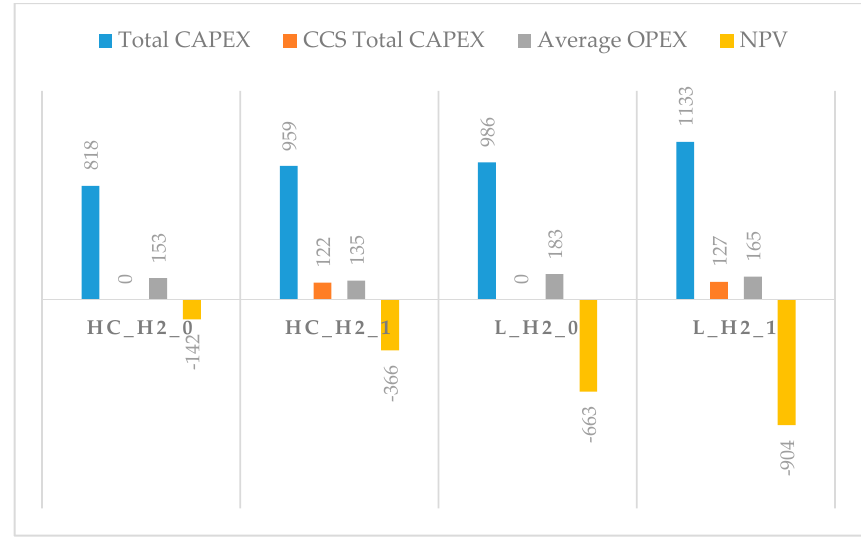
Figure 2. Summary of key economic parameters. Source: own study.